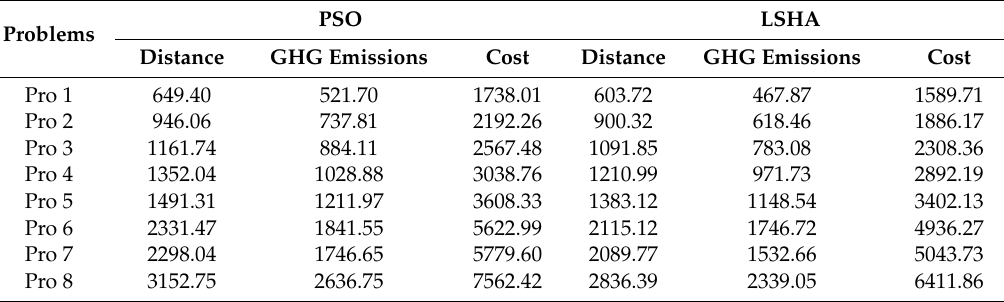
Table 8. Test results of PSO and